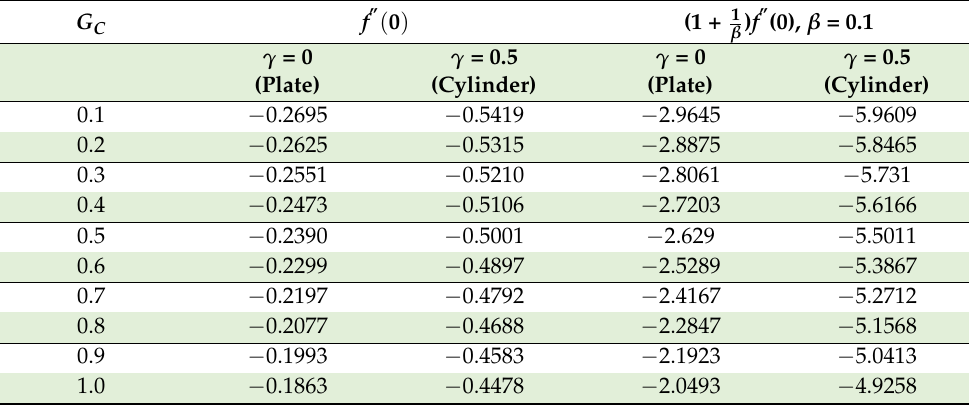
Table 4. Impact of G C on skin friction parameter when M = 0.